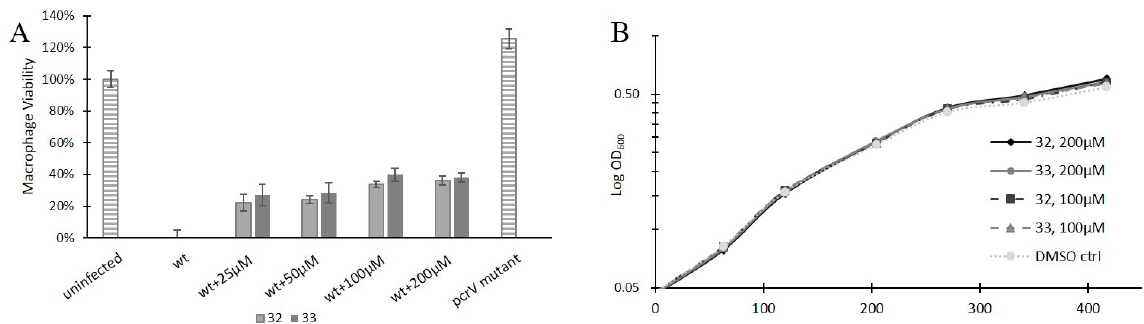
Figure 4. Compounds 32 and 33 inhibit cell infection without affecting bacterial growth. ( A ) Infection assay with dose-response analysis of compound 32 and 33 that protects macrophages from T3SS-mediated P. aeruginosa toxicity (wt): uninfected cells and infection with a pcrV mutant were used as controls, and standard deviation was calculated by Gaussian approximation. Each value represents the mean value of a triplicate. ( B ) Bacterial growth assay where P. aeruginosa was grown in the presence of compounds 32 and 33 at 200, 100, 50, and 25 µ M and OD600 was measured regularly for 8 h: each value represents the mean value of a triplicate; to the control wells, 1% DMSO was added (DMSO).